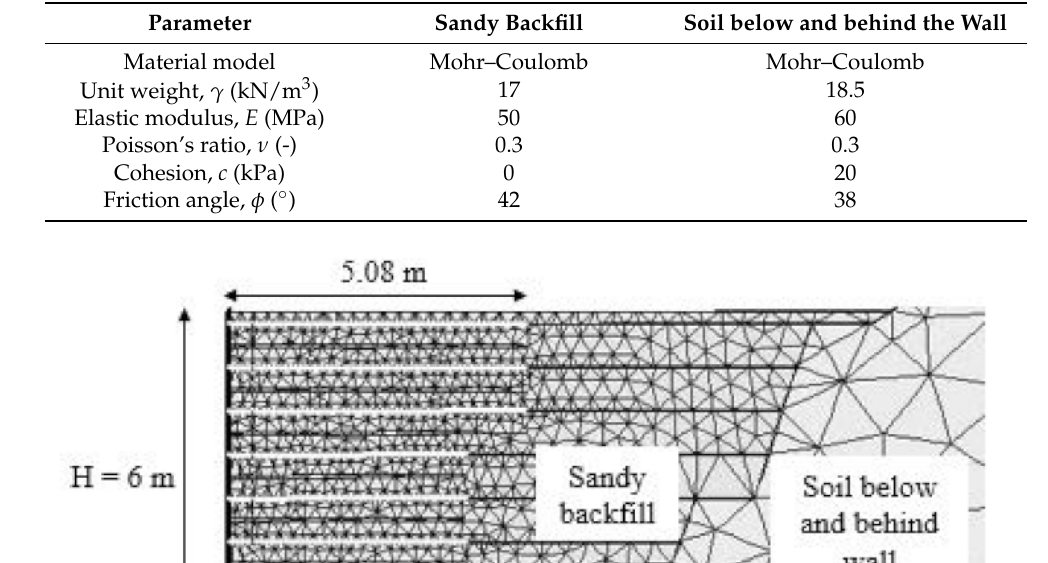
Table 4. Soil properties (taken from [24]).